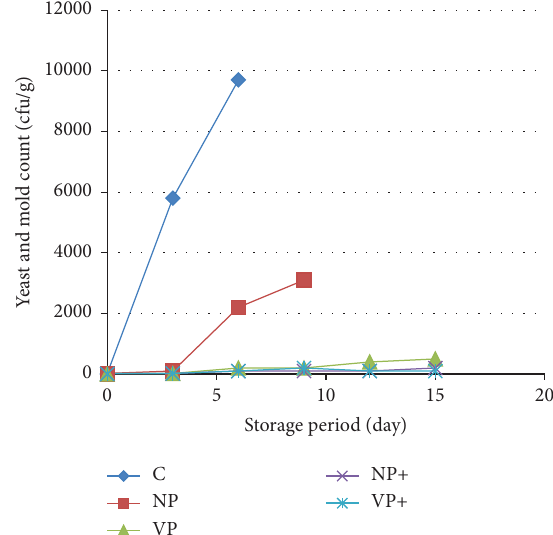
Figure 2: Colony forming units of yeast and mold/g of injera with respective treatments at diferent storage intervals. For “C” and “NP” treatments, the experiment was terminated at 6 th and 9 th day of storage, respectively, since the samples were